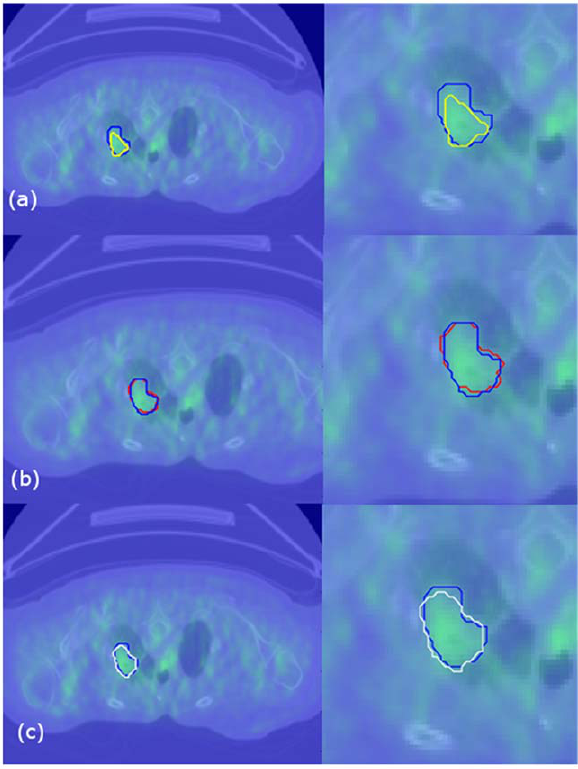
Figure 3. First row: an example inter-observer variation was demonstrated in fused PET-CT image (user 1: yellow, user 2: blue drawings). Second row: an example intra-observer variation was demonstrated (user 1 time 1: blue, user 1 time 2: red drawings). Third row: Users drawing (blue) and automatically found (white) boundaries of uptake regions were